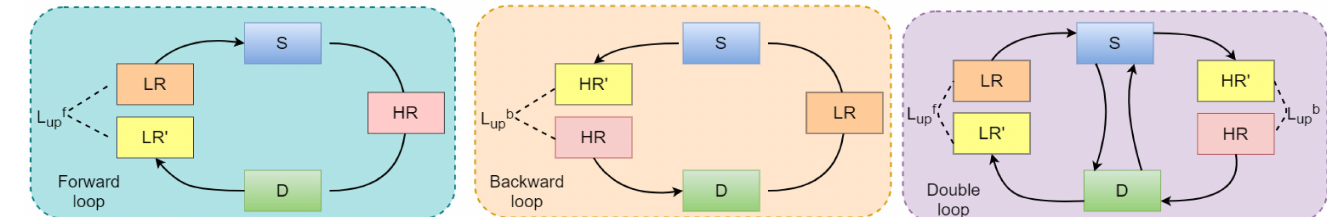
Figure 1. The cycle structure of our closed-loop framework. Our framework consists of two generative networks for super-resolution ( S ) and down-sampling ( D ), respectively. The left subfigure starting with the LR image is denoted as a forward loop, the center one starting with the HR image is denoted as a backward loop, and the right one is a double loop. L f up and L b up are loss functions denoted in Equations (1) and (2) separately.